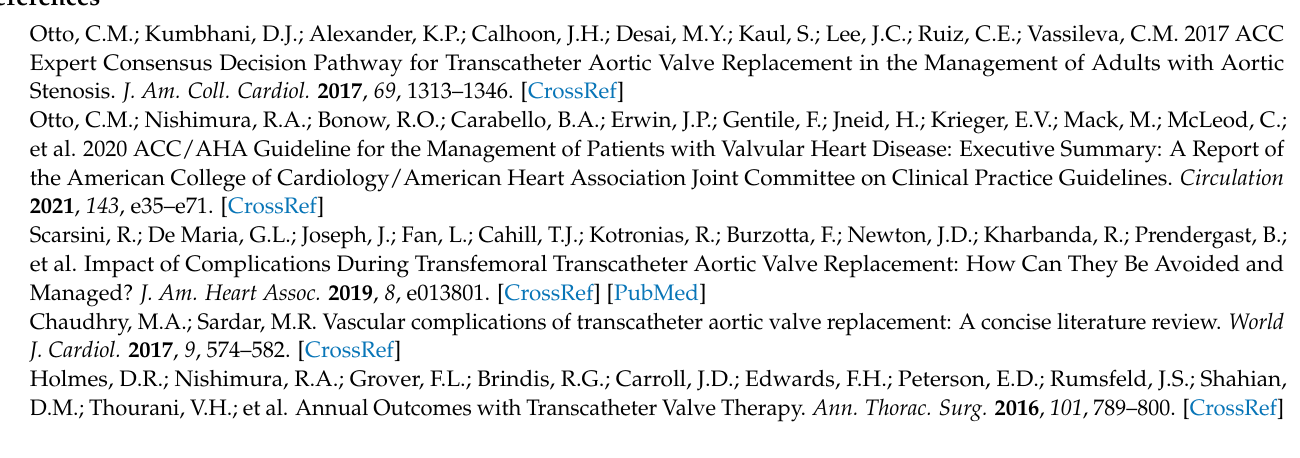
Figure S3: Digital subtraction angiography after the application of vascular closure device: A. opacification of the proximal part of common femoral artery; B. opacification of the distal part of common femoral